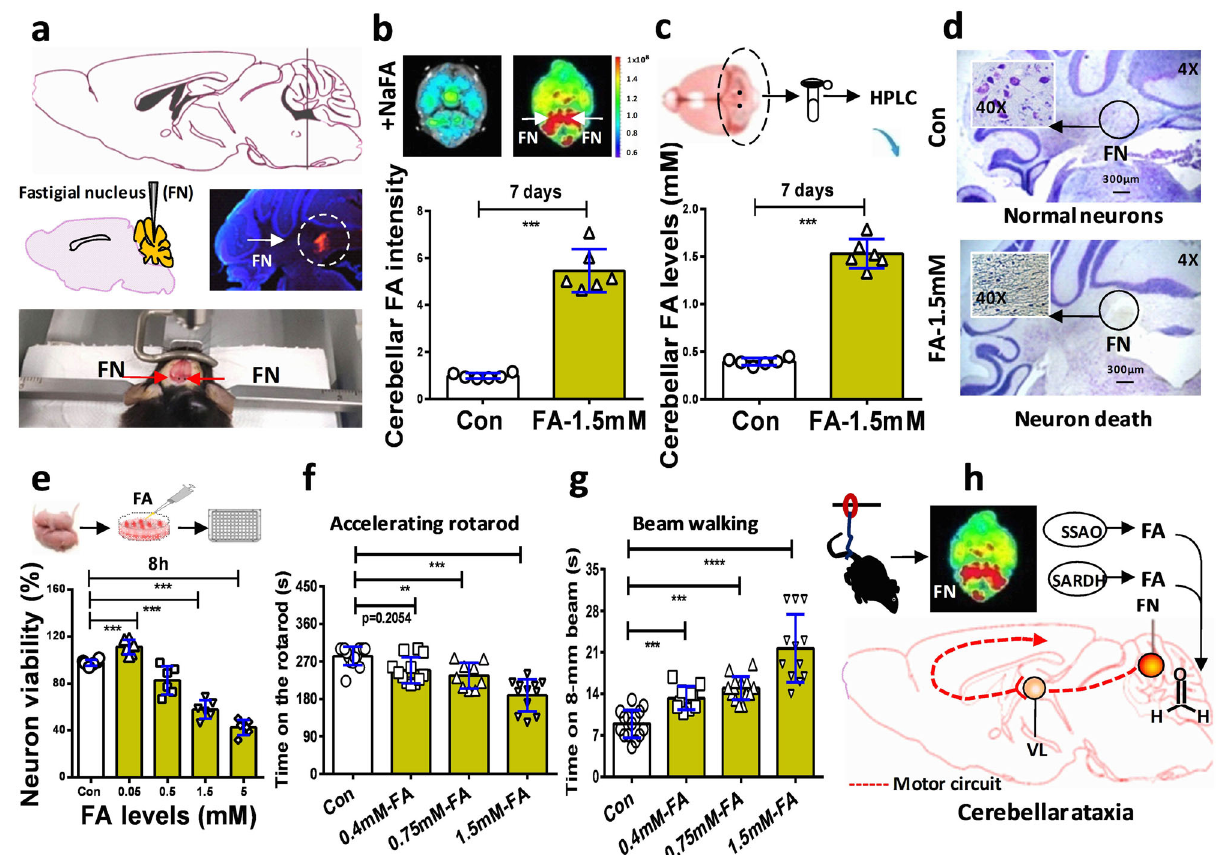
Fig. 6 Formaldehyde-infused into the fastigial nucleus promoted formaldehyde overload and motor de fi cits. a Location, microinfusion, and identi fi cation of the bilateral fastigial nucleus injected with formaldehyde. FN fastigial nucleus (location identi fi ed by using red fl uorescent probe-Dil to mark cell membrane and blue DAPI to stain nucleus). b Cerebellar formaldehyde quanti fi ed by an in-vitro small animal imaging system ( n = 6). FA-1.5 mM: the group of mice microinfused with 1.5 mM formaldehyde; Con PBS-injected group of mice, FA formaldehyde. c Formaldehyde levels in the cerebellum detected by HPLC ( n = 6). HPLC high-performance liquid chromatography. d Cellular morphology of the cerebellar neurons detected by using Nissl staining solutions ( n = 3). e Cell toxicity of formaldehyde detected by using a CCK-8 kit ( n = 6). f Motor behaviors assessed in FA-injected mice by the accelerating rotarod test ( n = 10). g Motor functions in FA-injected mice evaluated by the beam walking test ( n = 10). h The model of FN impairments results in cerebellar ataxia induced by HU-derived formaldehyde. VL ventrolateral nucleus of the thalamus. Error bars show the mean ± SEM; ** p < 0.01; *** p <